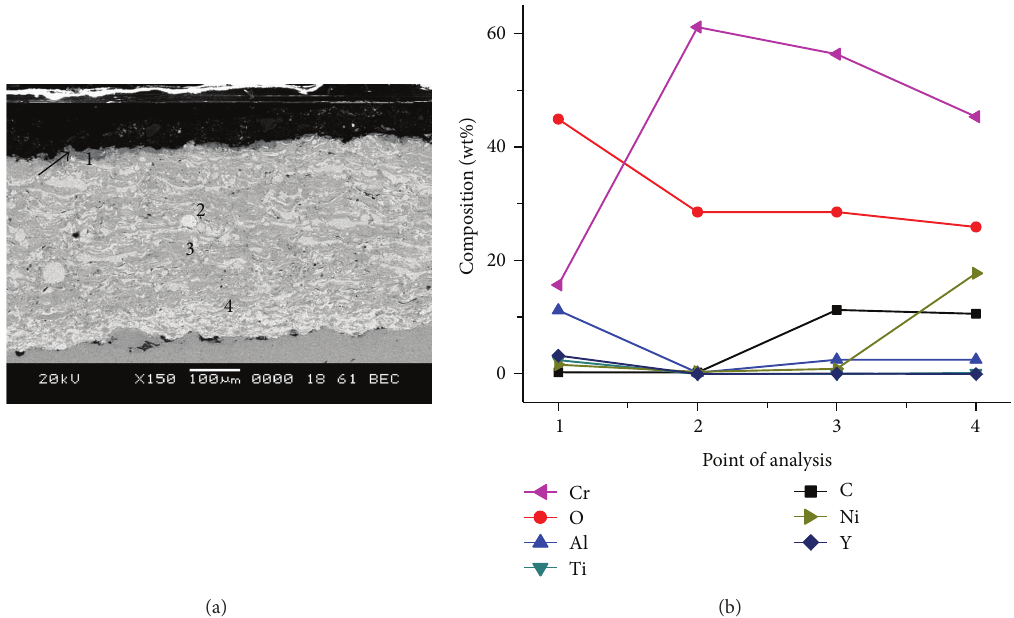
Figure 12: Cross-sectional micrograph of the HVOF coated and hot corroded Ti-31 sample. (a) Micrograph and points of EDX analysis, (b) plots of EDX analysis at various points.